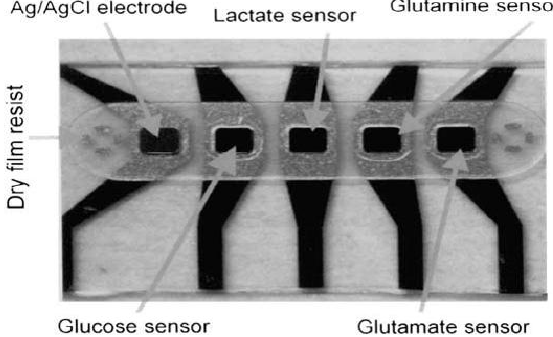
Figure 7. The biosensor array with glucose, lactate, glutamine, and glutamate sensor